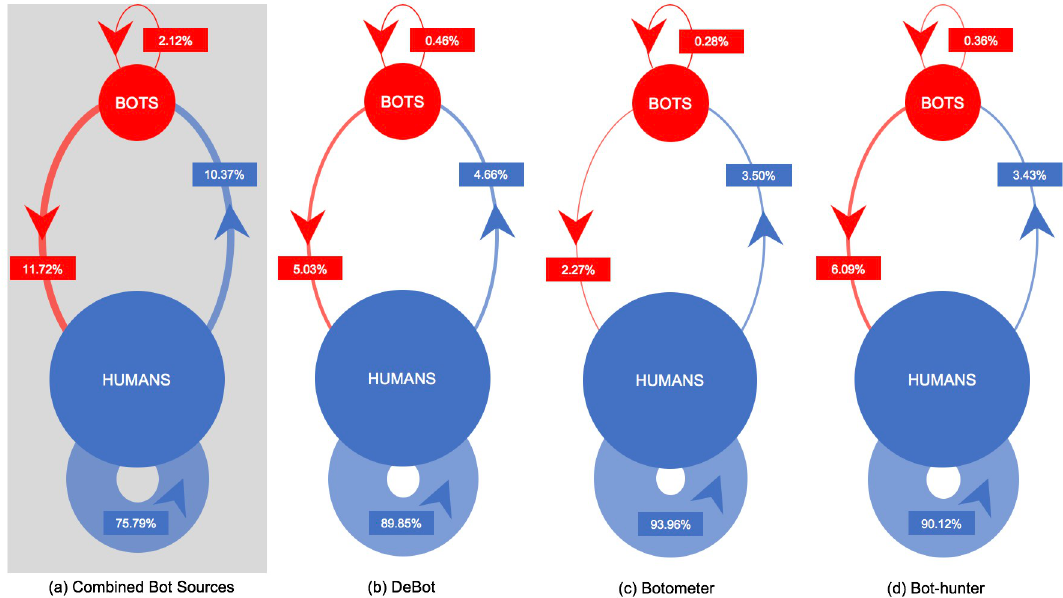
Fig 4. Intra-group and cross-group retweet communication patterns of human (blue) and social bot (red) users within the 2018 U.S. midterm election Twitter conversation according to each bot detection classification platform: (a) Combined Bot Sources (b) DeBot (c) Botometer (d) Bot-hunter. The combined bot sources results (shown in gray) classified an account as a bot in aggregate fashion if any of the three detection platforms classified the account as a